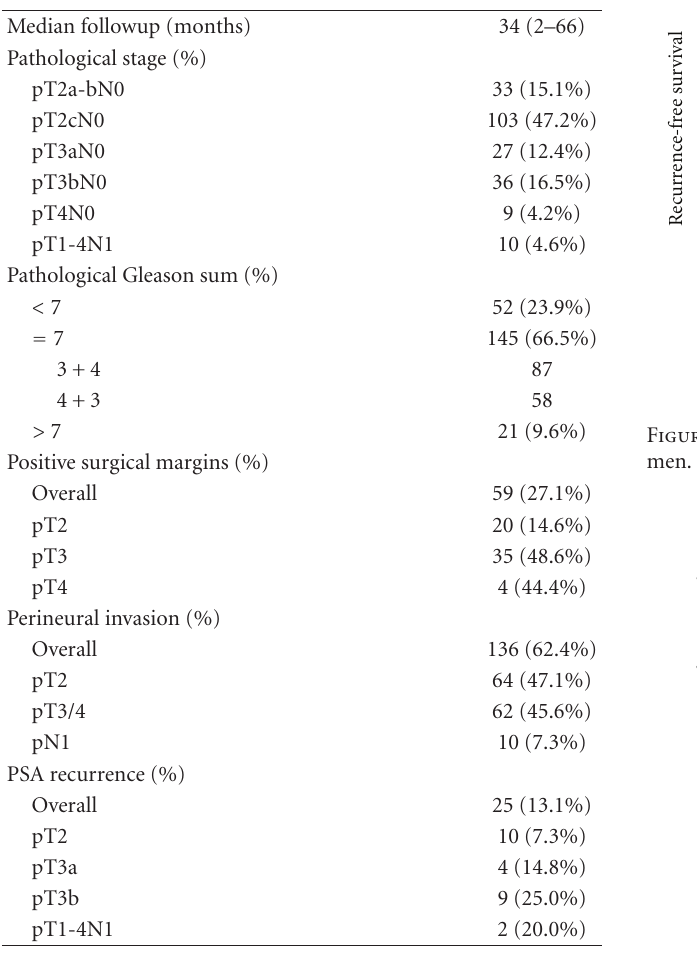
Table 2: Pathological and oncologic outcomes.